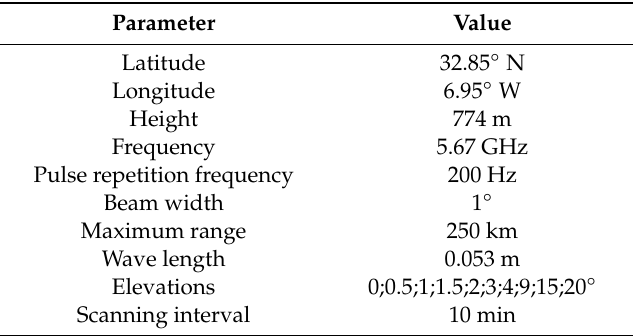
Figure 1. Study area, including orography. The blue circle represents Khouribga City’s radar coverage at 150 km, the red diamond refers to the radar’s location, whilst the black dots indicate the rain gauges location. Table 1. Technical specifications of the Khouribga City